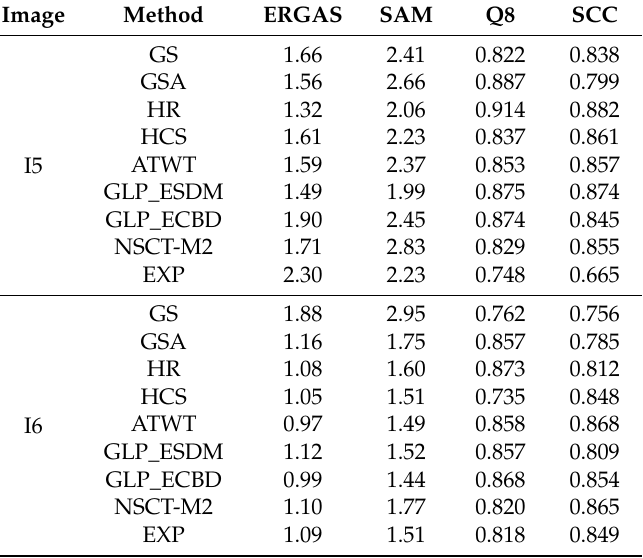
Table 4. Quality indices of the fused images generated by the selected algorithms for the two rural